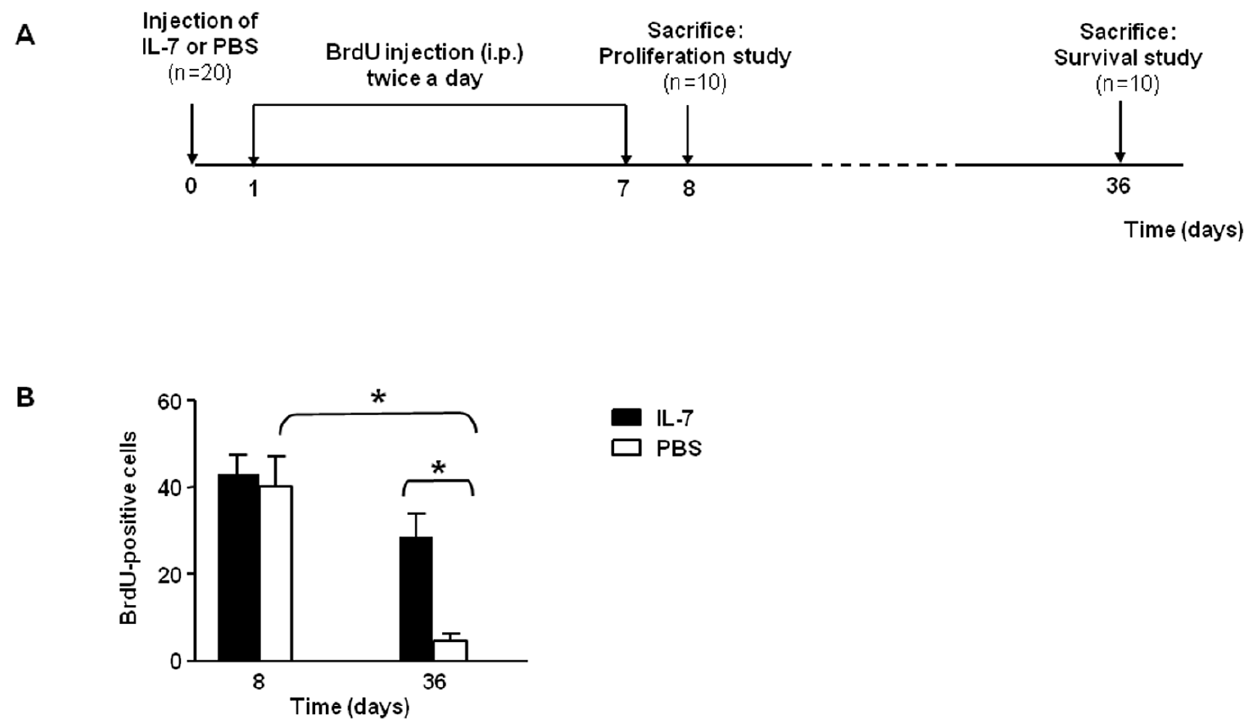
Figure 2. IL-7 improves neural cell-survival. ( A ) Bromodeoxyuridine (BrdU) treatment experimental procedure. ( B ) BrdU positive cells in the ARC of PBS- ( % ) or IL-7- ( & ) treated mice. Animals were sacrificed one day after BrdU treatment (post-natal day 8 (P8)) for neural cell proliferation analysis (n=5 per group), or 29 days after BrdU treatment (P36) for neural cell survival analysis (n=5 per group). Data were represented as mean 6 SEM of BrdU-positive cells within the ARC per animal and per slice. * p ,